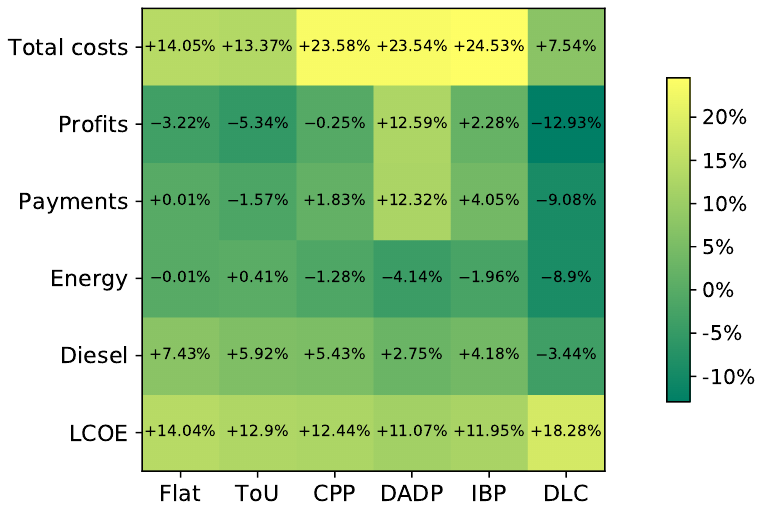
Figure 13. Percentage differences between the results of the first level and the third level for the five DSMs and the base